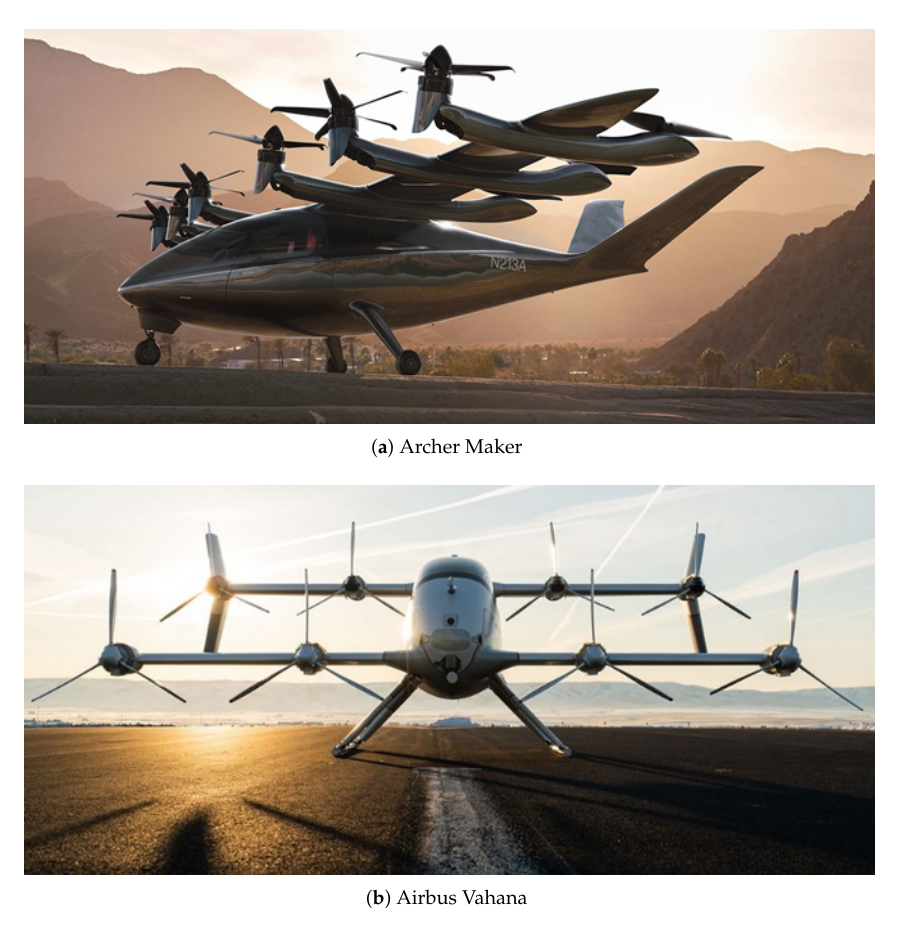
Figure 1. Examples of side-by-side propeller configurations in an eVTOL aircraft (pictures from https://evtol.news/aircraft, accessed on 28 August